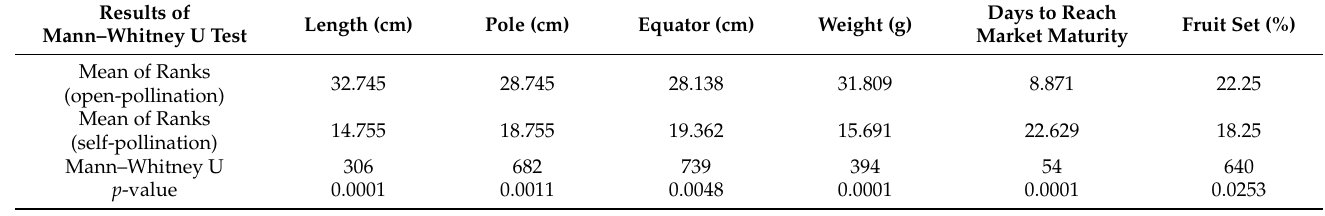
Table 4. Comparison of mean of ranks of physical parameters of strawberry fruits between open- and self-pollination treatments.